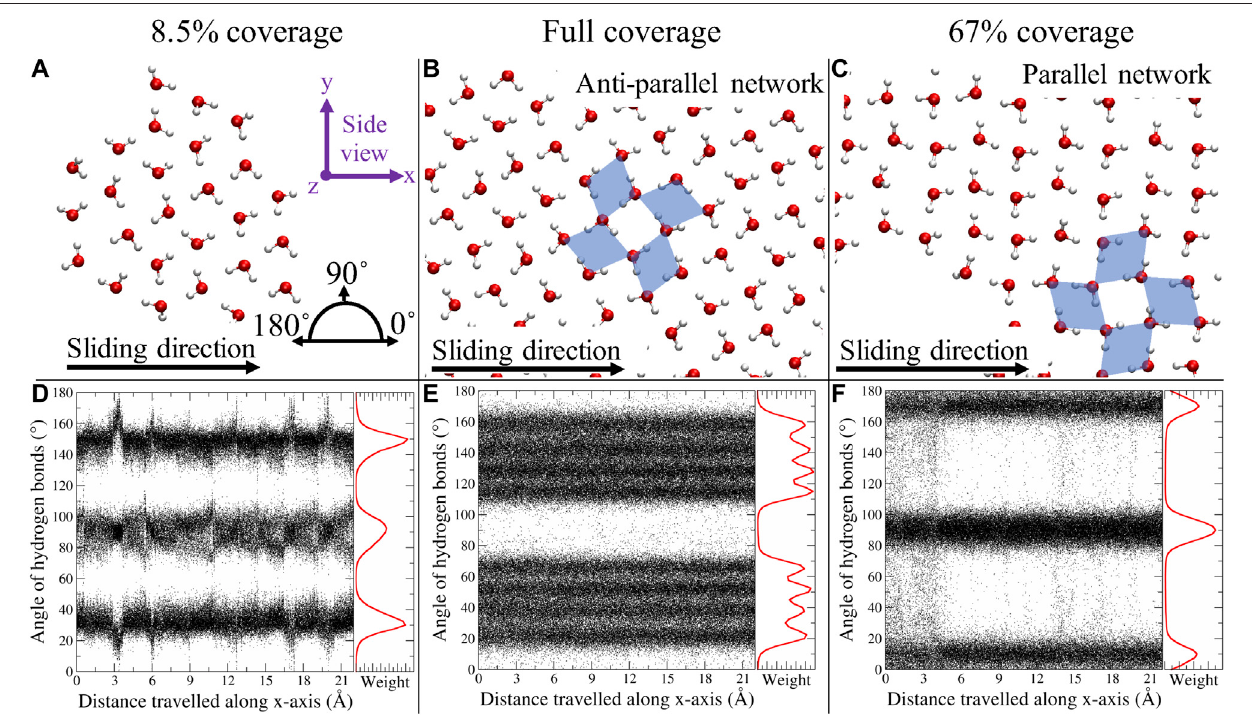
FIGURE 4 | Top view representation of the water network for 8.5%, full, and 67% coverage (A – C) . The black arrow represents the sliding direction. The blue diamondsserveasaguidetotheeyesindistinguishingthepcdcon fi guration.Thebottomrow (D – F) representstheanglesofallHbonds,ateverytimestep,withrespect to the x -axis; in red, the corresponding histograms are depicted. Figure was obtained with VMD (Humphrey et al., 1996).